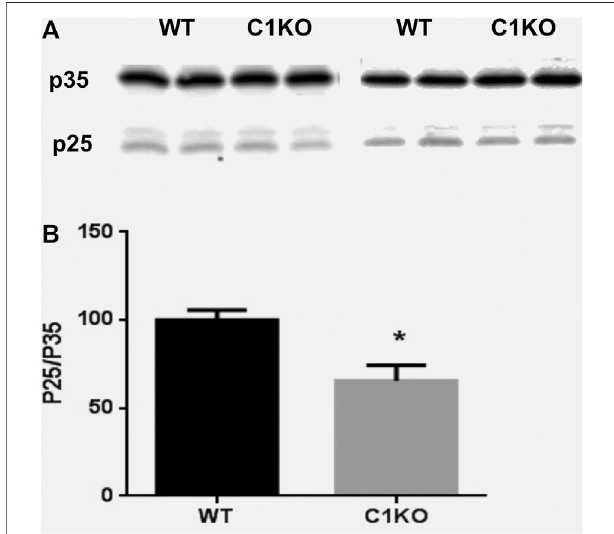
FIGURE4| Levelsofp35andp25inthehippocampusofWTandC1KO mice. WT and C1KO mice were sacri fi ced, and their hippocampi collected. They were homogenized and aliquots of the homogenates processed for immunoblotting with p35 antibodies (A) . (B) Quanti fi cation analysis. Ratios of p25/p35 were calculated and results were expressed as percent of the averaged value in WT mice and represent Means ± SEMof 4 animals. * p < 0.01, Student ’ s t-test.